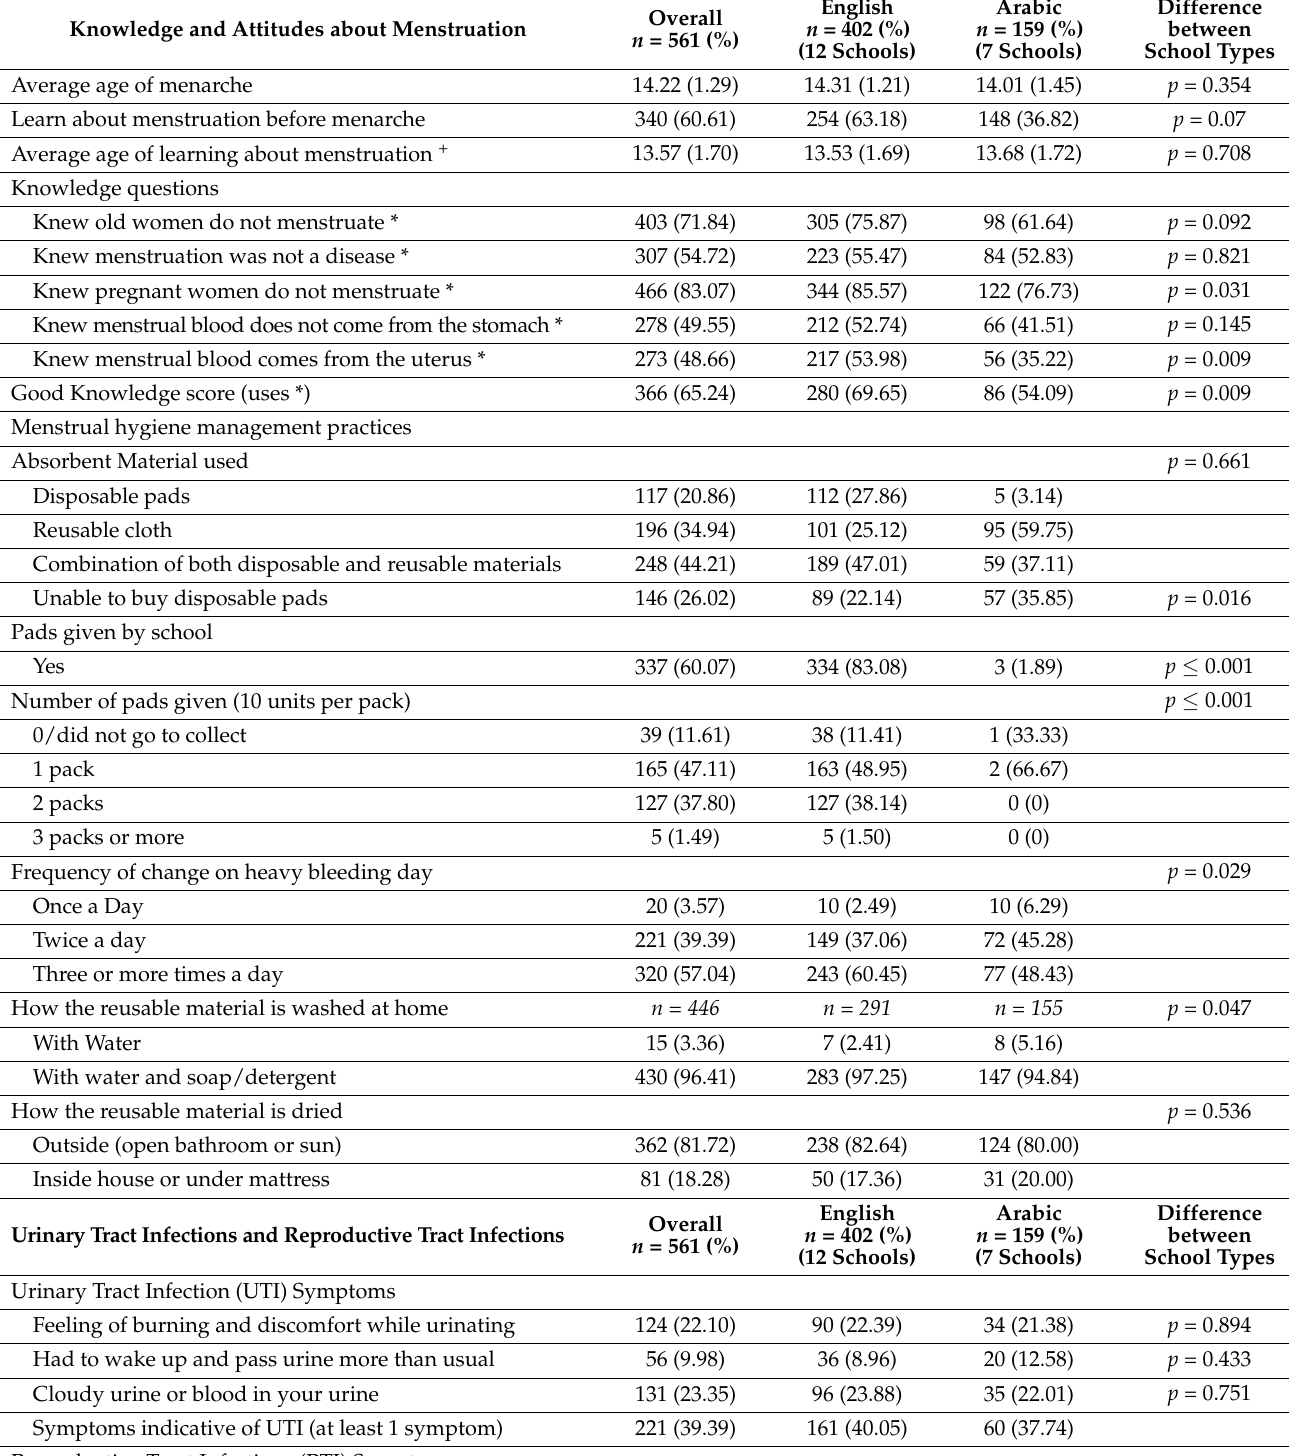
Table 3. Menstrual knowledge, practices, attitudes, and urogenital symptoms of study